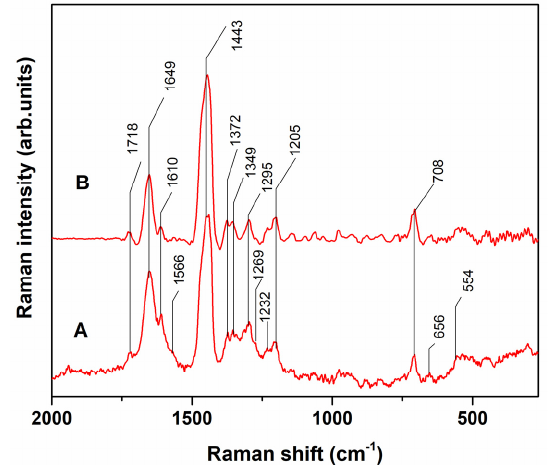
Figure 2. Comparison of Raman spectra of fossil resin from Sakhalin (Russia) collected with laboratory (A) and handheld (B) equipment. Minerals 2020 , 10 , 104